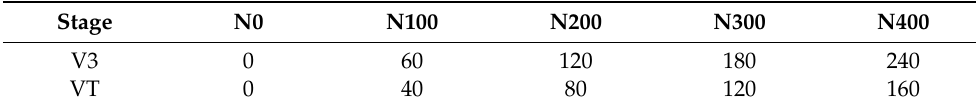
Table 1. Nitrogen treatments (kg/hm 2